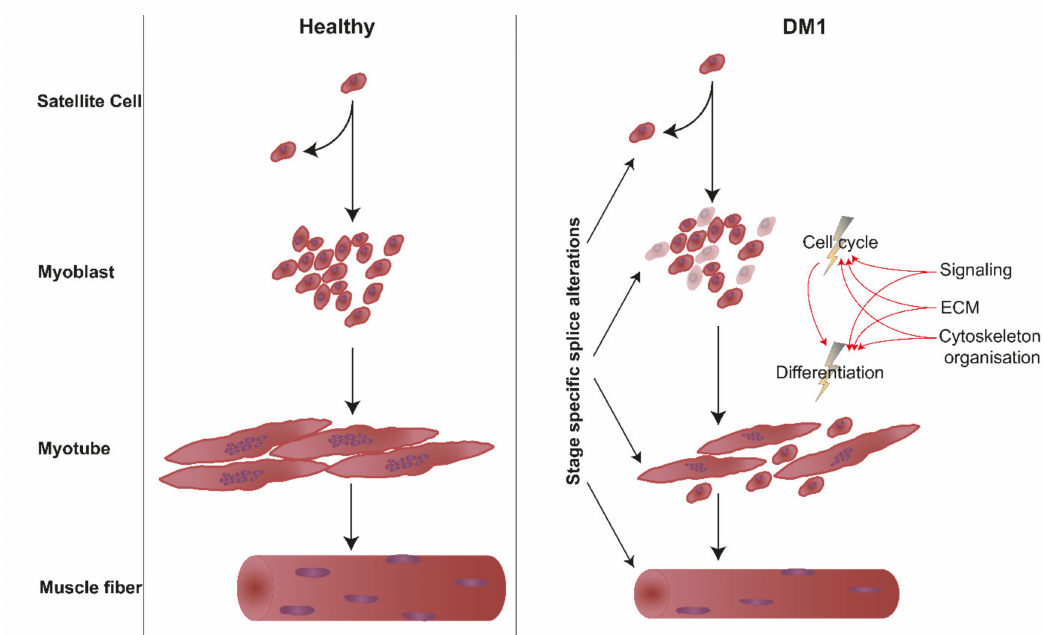
Figure 6. Hypothetical effect of the observed misregulated pathways on the cell cycle and differentiation leading to the DM1